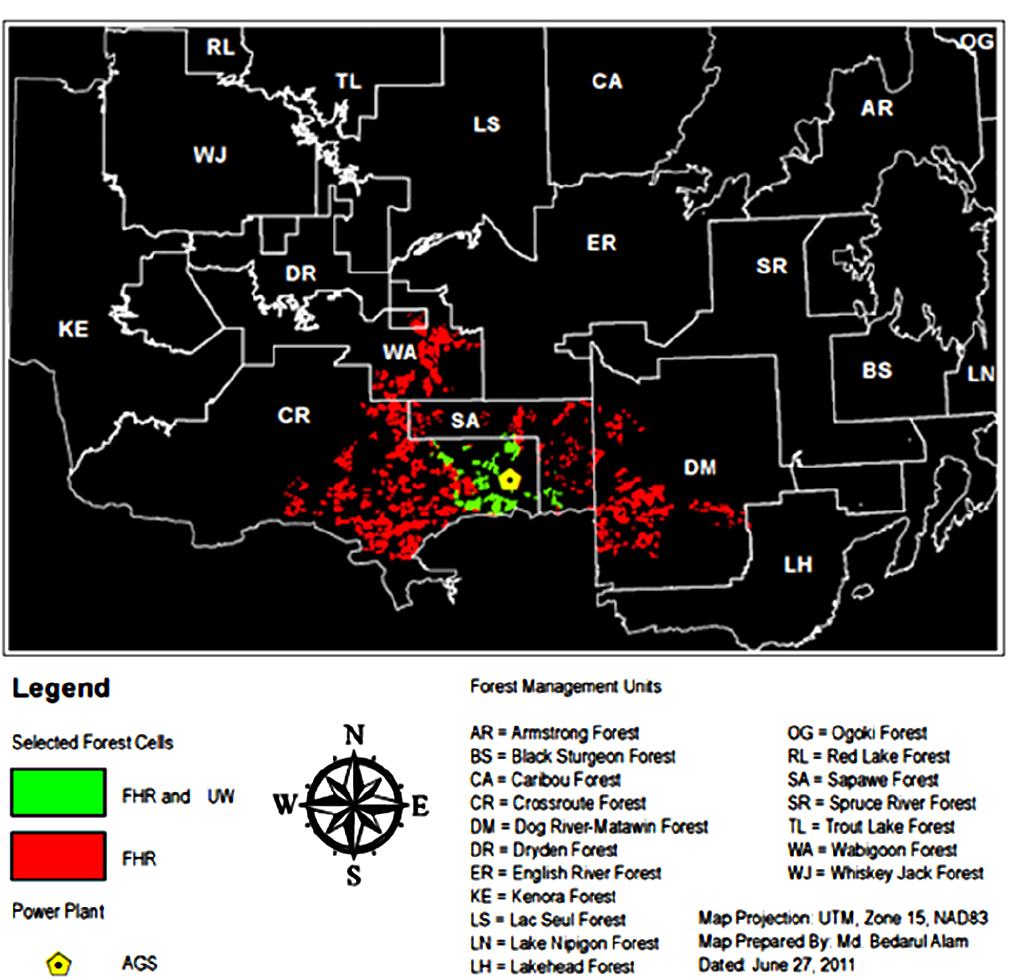
Figure 4. Selected forest cells to harvest FHR and UW for the AGS (BASE Scenario).